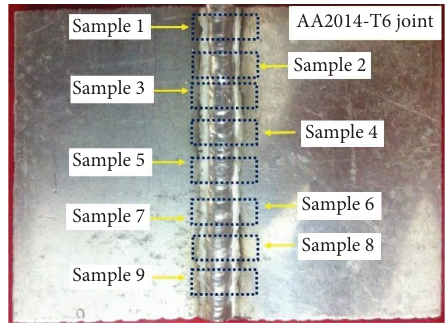
Figure 5: Photograph of the joint.